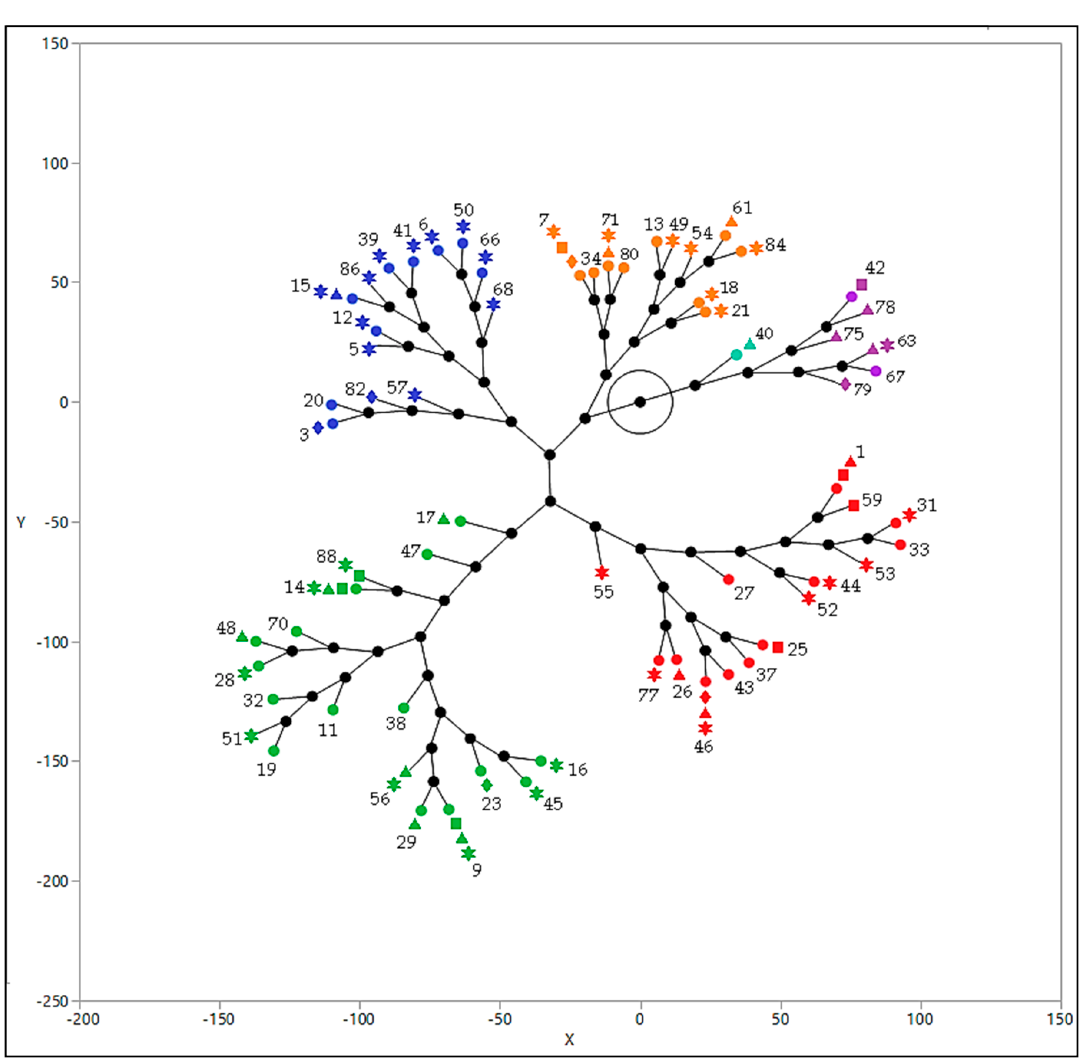
Figure 2. S. cerevisiae strains distribution in organic wineries from Galicia: phylogenetic tree in constellation formation. rhombus-CO; square-DL; triangle-AB; circle-PV; star-QM.